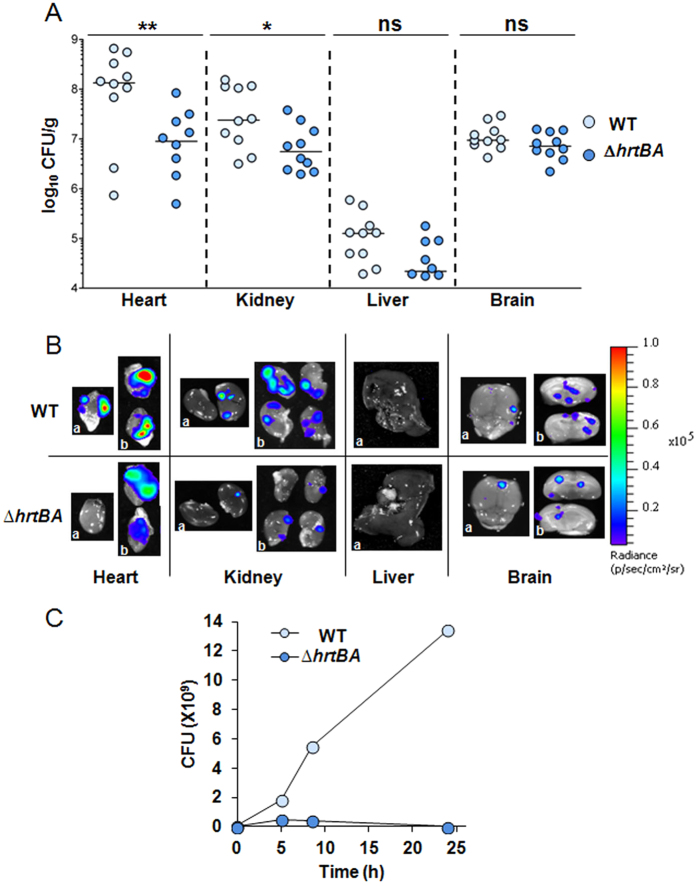
GBS depends on HrtBA expression to colonize host blood-rich organs.(A) Organ CFU of WT and ΔhrtBA GBS strains at 13 h post-infection. Mice infected as described in Fig. 2B were euthanized at 13 h post-infection. Dissected organs were homogenized and processed for CFU determinations (Methods). Symbols represent data from n = 8 to 10 mice from 3 independent experiments. Two tailed Mann–Whitney was used to determine P values: heart, P = 0.009; kidney, P = 0.029; liver P = 0.067; brain, P = 0.19. *P < 0.05; **P < 0.01; ***P < 0.001; ns, not significant (P > 0.05). (B) Bioluminescence from dissected organs. Indicated organs were imaged with the IVIS 200 (acquisition time, 5 min; binning 8). Representative organs from systematically infected mice sacrificed 13 h following the start of infection as in (B). a, top view; b, cross section of the indicated organs. (C) Growth of WT and ΔhrtBA in mouse blood. Bacteria from an ON preculture were diluted to an OD = 0.01 in 1 ml of freshly collected (<24 h) and heparinized blood of 6 weeks old BALB/c mice (Janvier, Le Genest Saint-Isle, France). At the indicated times, 100 μl of the culture was serially diluted and plated on agar plates for determination of the CFU. Results are representative of three independent experiments.